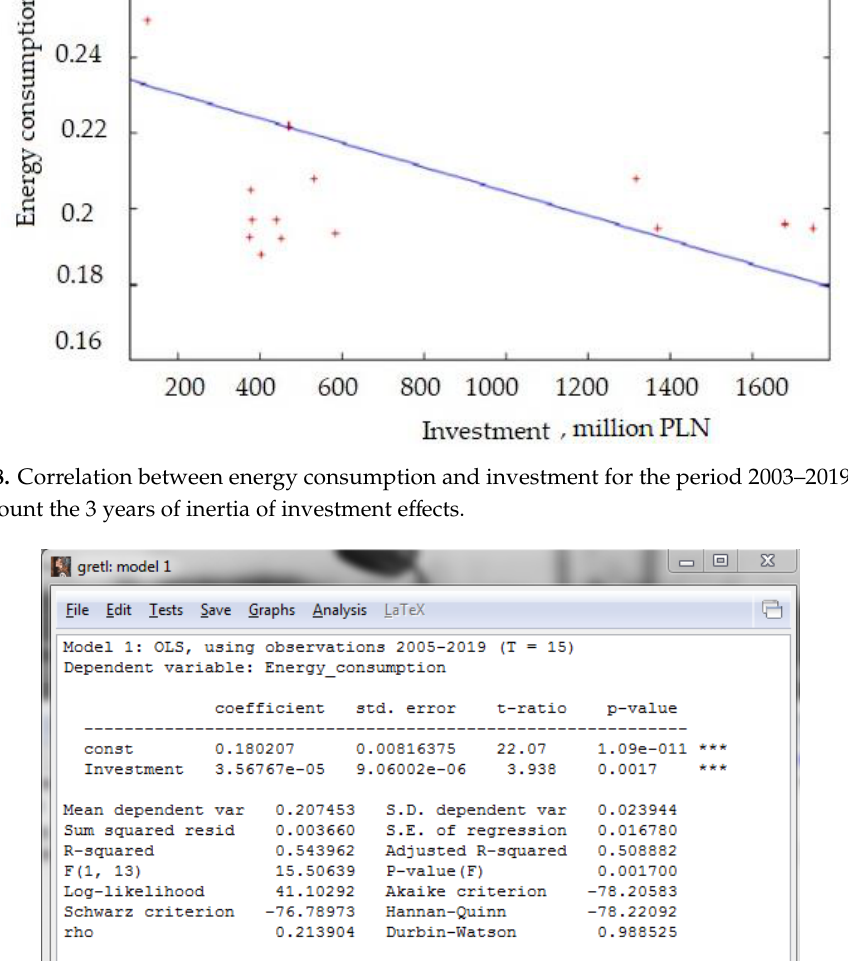
Figure 8. Correlation between energy consumption and investment for the period 2003–2019 taking into account the 3 years of inertia of investment effects.